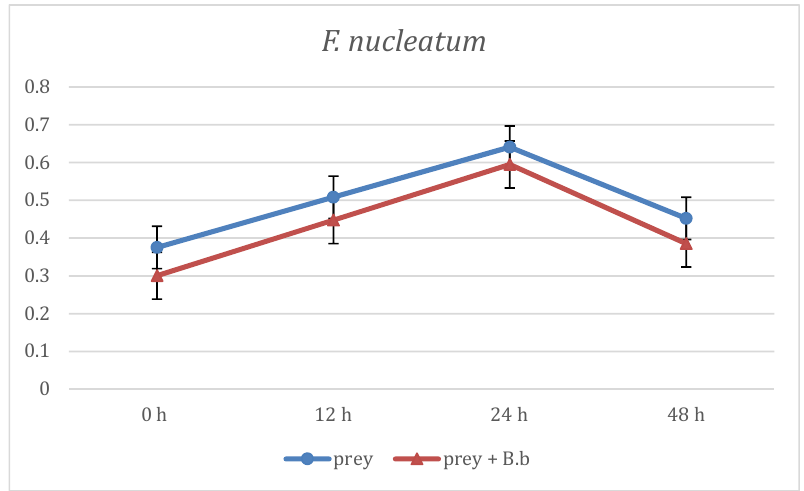
Figure 5. Predation activity of B. bacteriovorus against P. gingivalis .